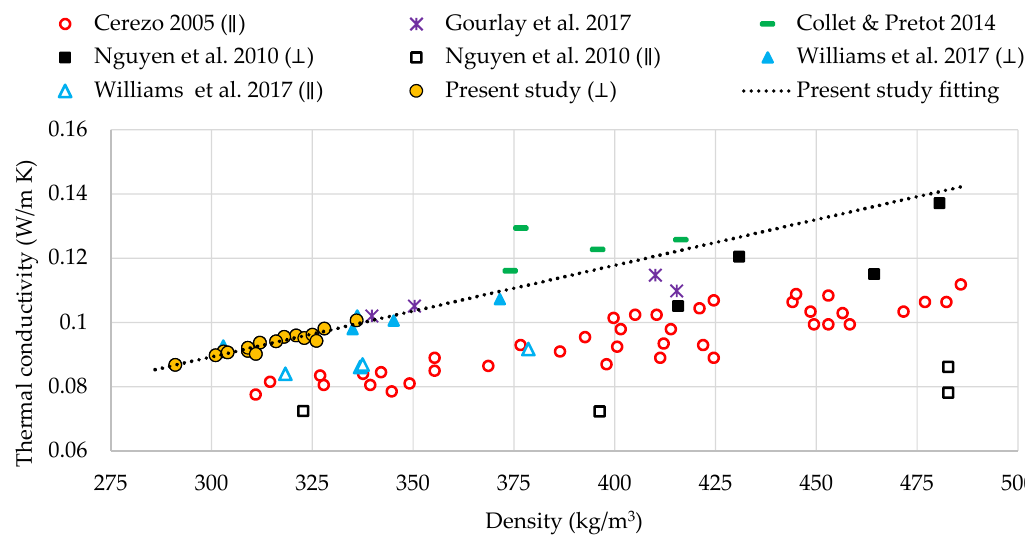
Figure 4 . Thermal conductivity comparison with other studies. Figure 4. Thermal conductivity comparison with other